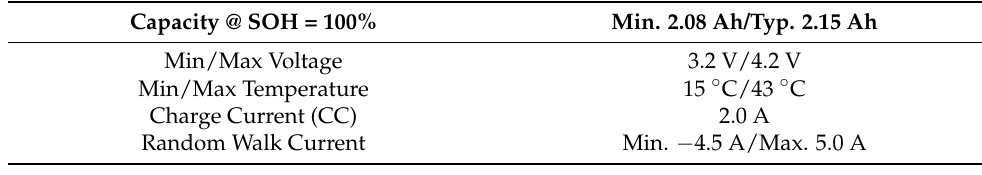
Table 1. Randomized Battery Usage Dataset parameters.